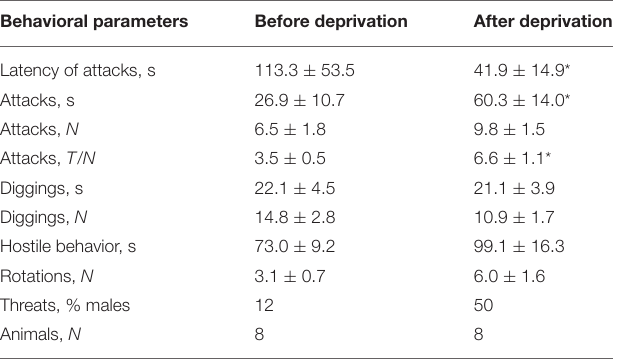
TABLE 3 | Behavior of Win21 C57BL/Icg male mice in the agonistic interaction test before and after deprivation. Behavioral parameters Before